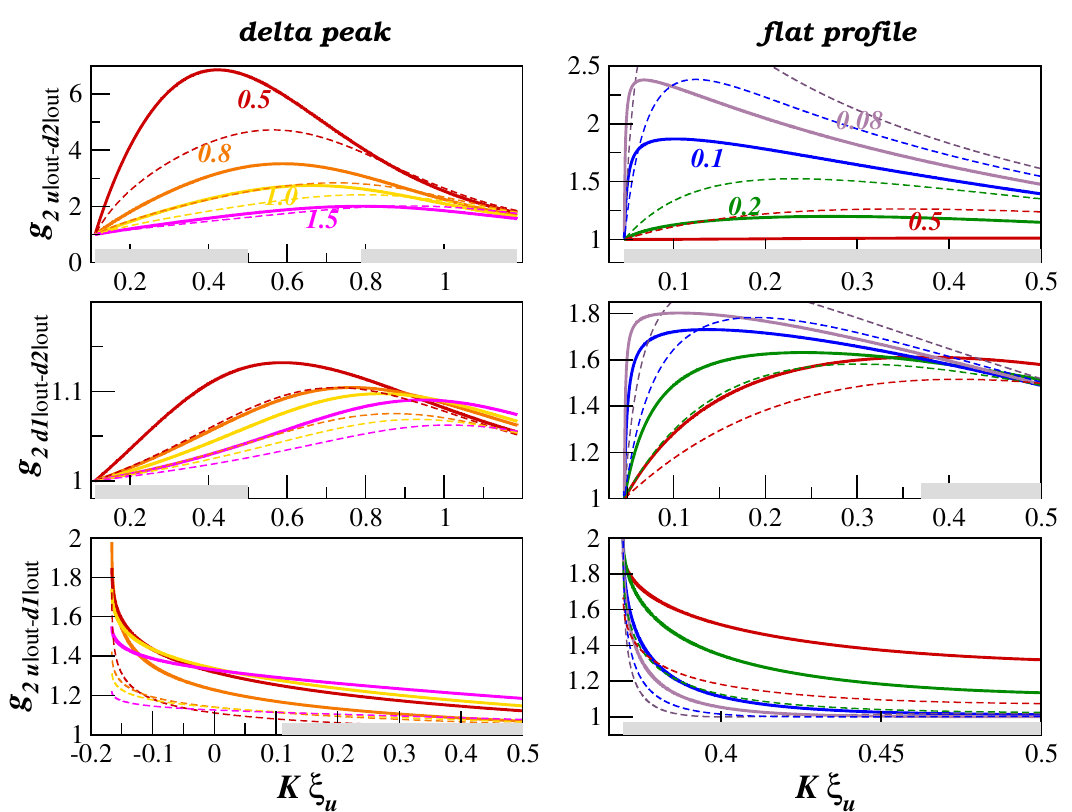
Figure 7: Same as Fig. 7 for a δ -peak configuration (left plot) and a flat profile one (right = 0.5 and M = 1.827 in both plot). M u d